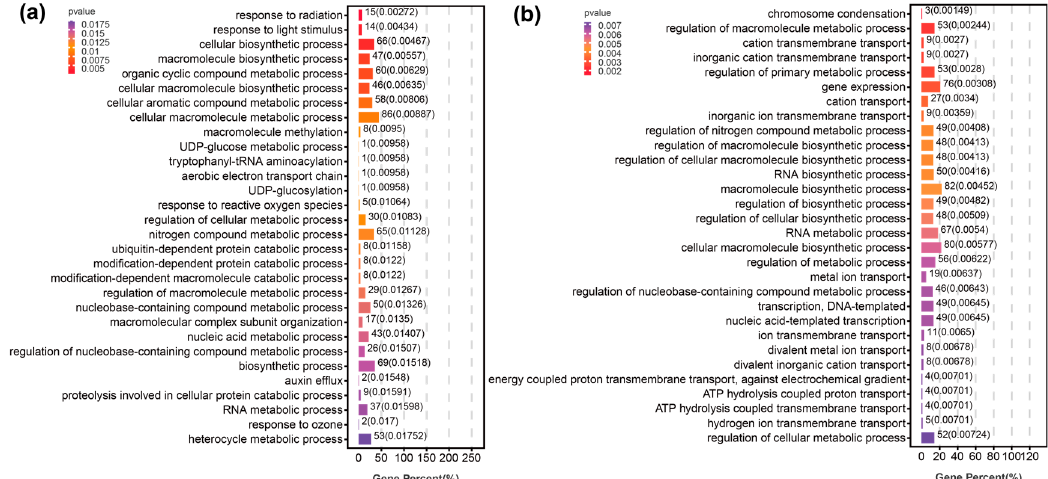
Figure 5. Annotation based on the GO database. The Y -axis indicates the top 30 GO terms, and the X -axis indicates the numbers of genes annotated to the terms and their P values: ( a ) MKS population; ( b ) WYL population.